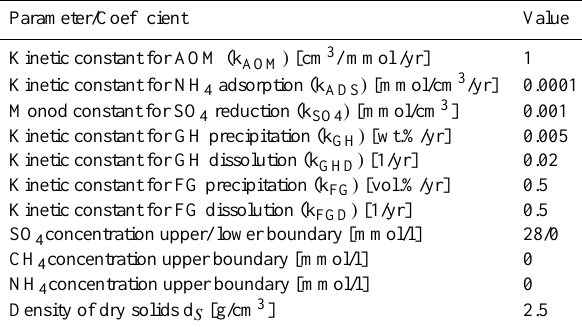
Table A4. Boundary conditions and constants used for all model runs. Nomenclature after Wallmann et al.